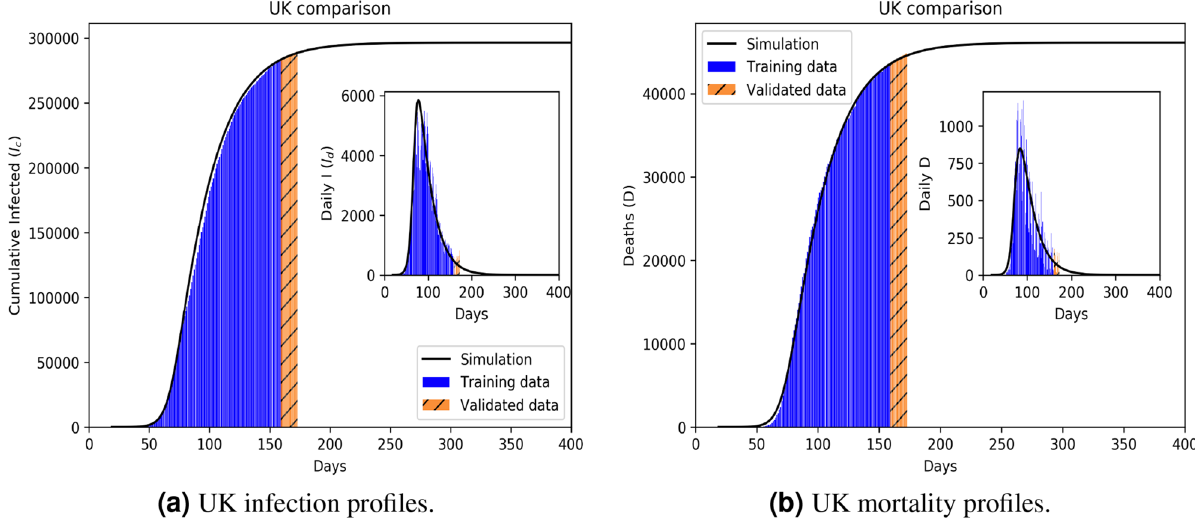
Figure 2. Infection ( a ) and mortality ( b ) epidemiology for the UK (Class A). Outsets represent cumulative statistics while the insets are for daily updates in the number of infected and death respectively. Here “0” marks